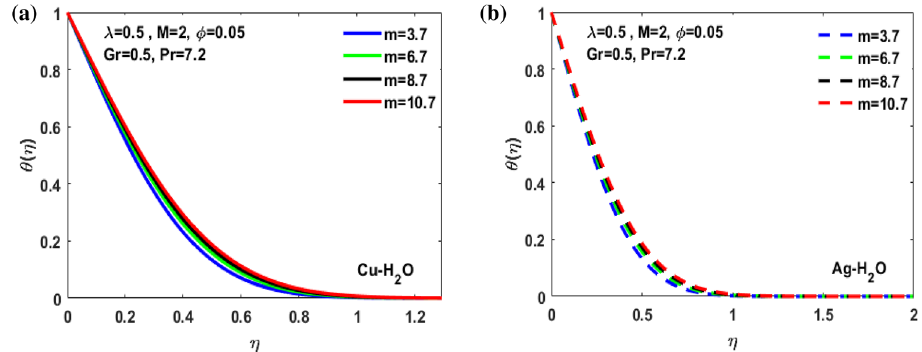
Figure 9. ( a ) Inspiration of m on θ ( η ). ( b ) Inspiration of m on θ ( η ).